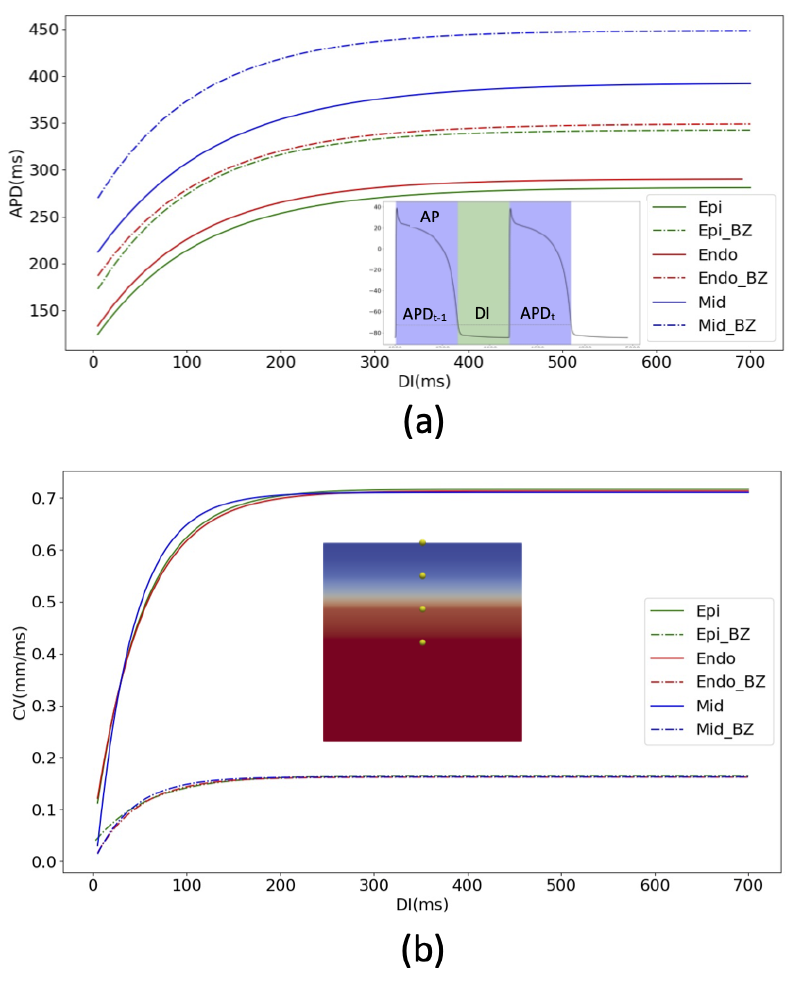
Figure 1. Restitution curves obtained from 3D biophysical simulations based on ten Tusscher model [21]. ( a ) displays APD restitution curves for the three cell types (endocardial, midmyocardial, epicardial) in healthy (solid lines) and pathological conditions (BZ, dashed lines). ( b ) CV restitution curves for the same types of cells, together with the 3D slab model used to perform all the biophysical simulations and measurements and with the location of the probes. Red color represents activated tissue, and blue color shows tissue in resting